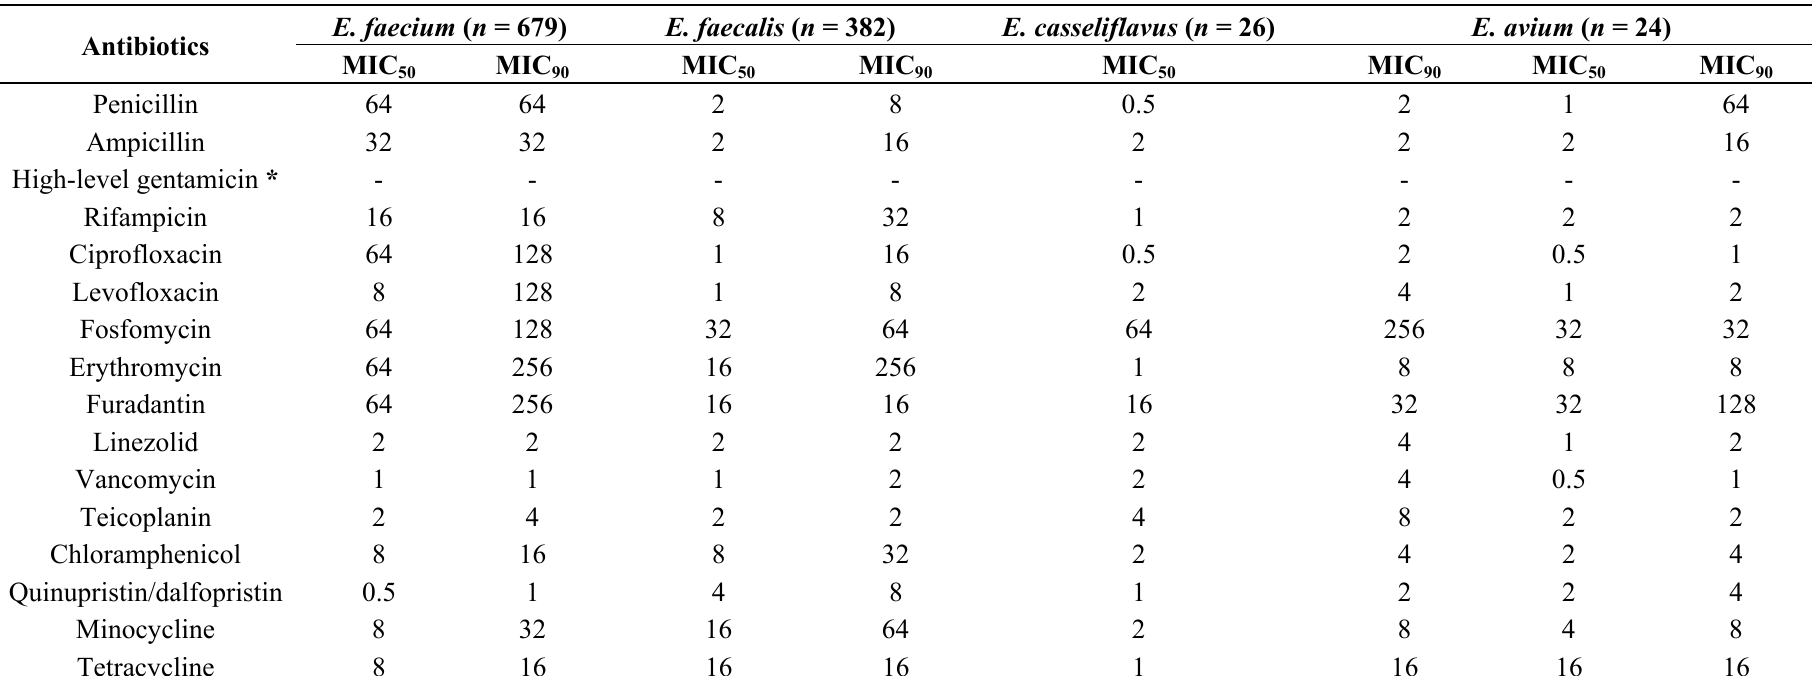
Table 3. MIC and MIC scales of 16 antibiotics against Enterococcus species (µg/mL). 50 90